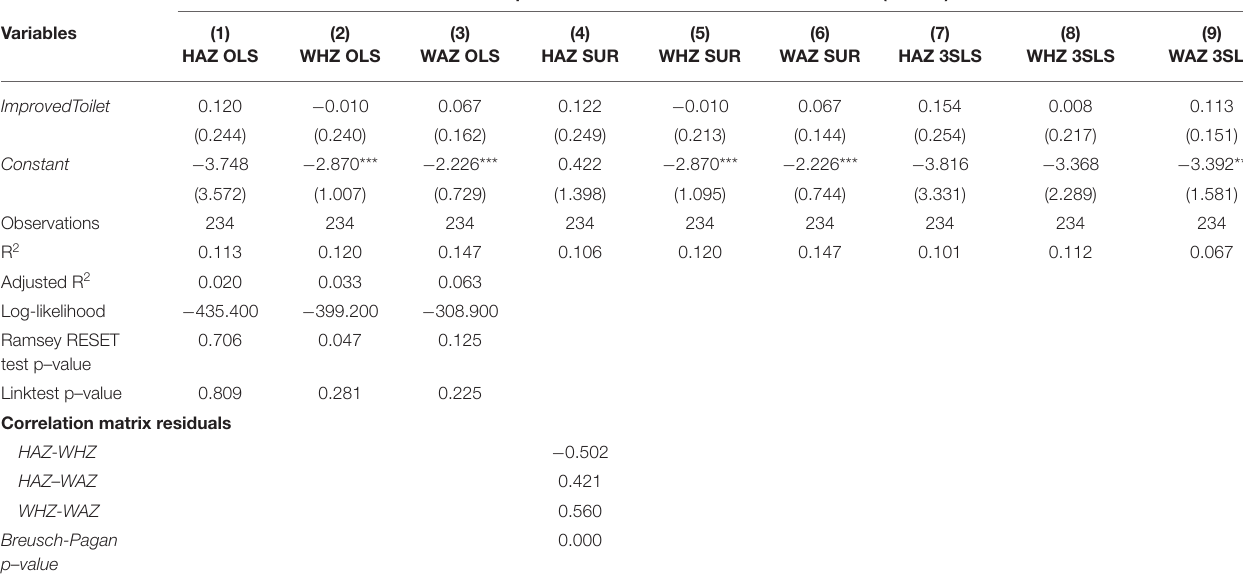
Dependent variables and estimators: Z-scores (Pooled)